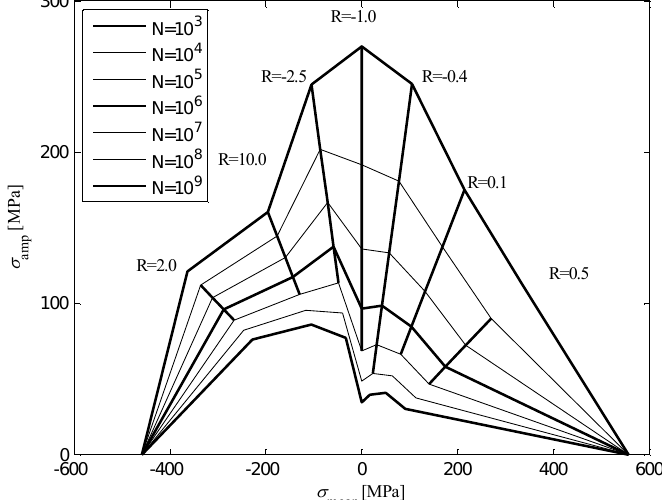
Figure 1. Constant life diagram for geometry R04